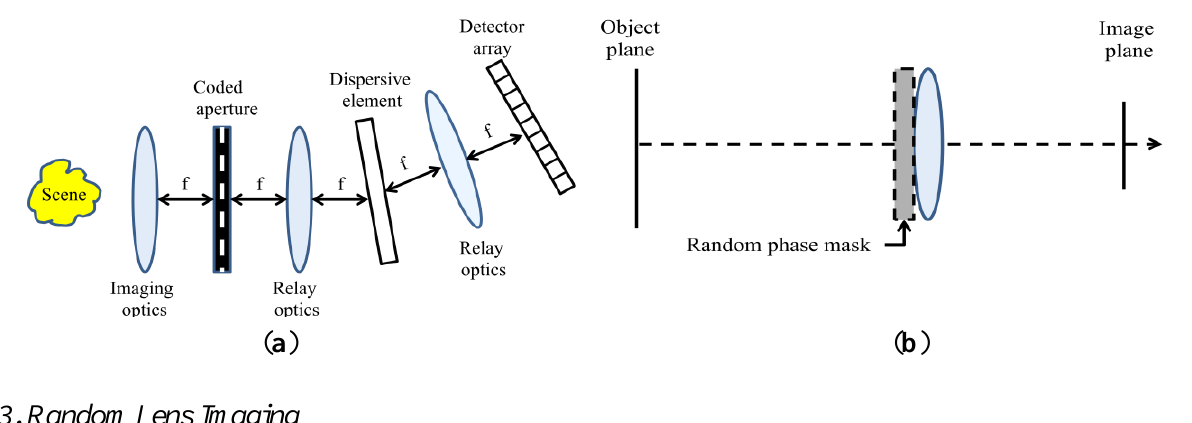
Figure 2. ( a ) Schematic of single dispersive spectral imaging system (adapted from [49]); ( b ) Optical set - up for random-mask image acquisition (adapted from